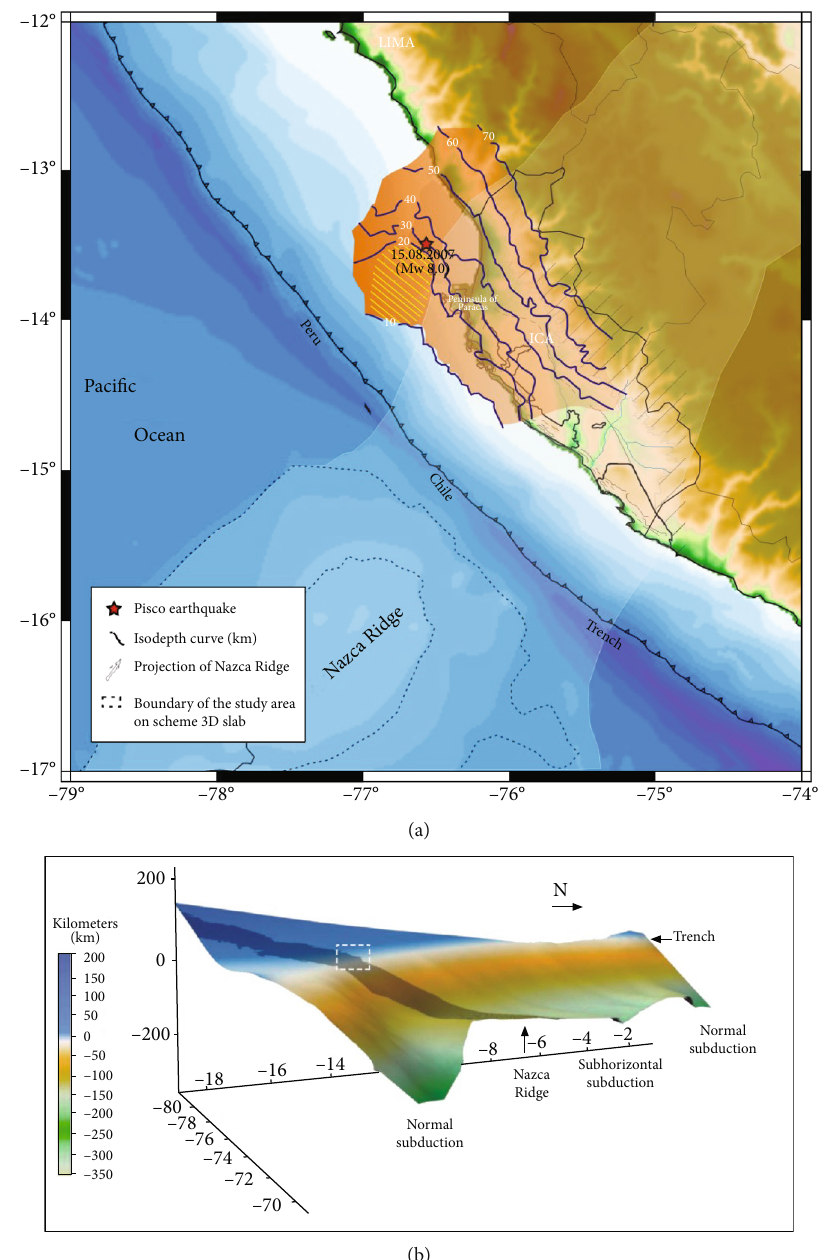
Figure 4: Geometry of the subduction slab in the area of the Pisco earthquake. (a) The dark blue lines show the isocontours of the slab geometry every 10 km of depth. The dashed lines extend toward the continent of the axis of the 3 km bathymetric contour of the Nazca Ridge, and the yellow lines de fi ne the convex area of the slab. (b) The white square shows the area of study on the geometry of the slab subduction in the Peru